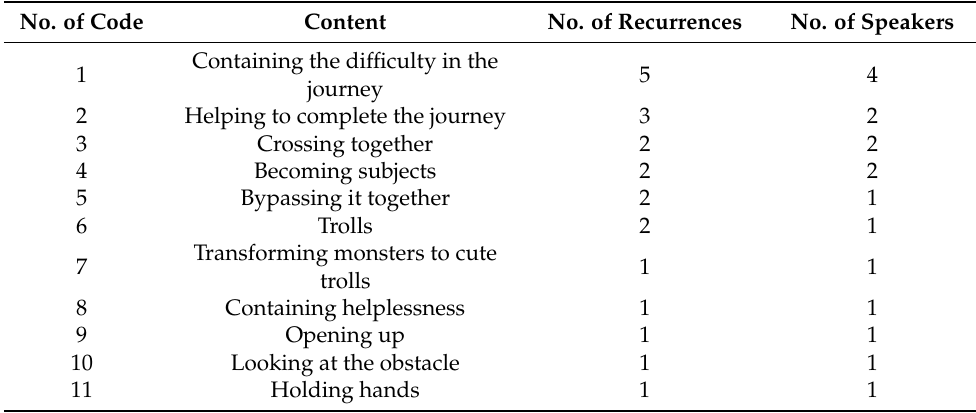
Table A5. Category E: Request for